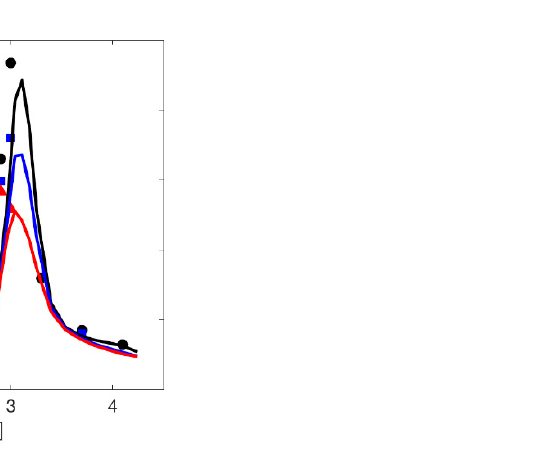
Figure 9. Response amplitude operator (RAO) heave motion result comparisons between the ex- periment and NK-UTWind numerical calculations for different wave heights.